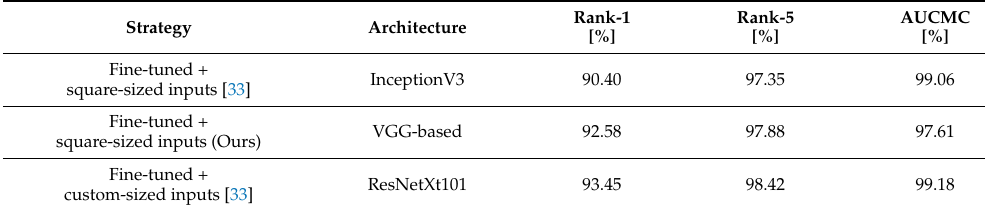
Table 9. Comparative evaluation with methods in the state-of-the-art over the EarVN1.0 dataset test